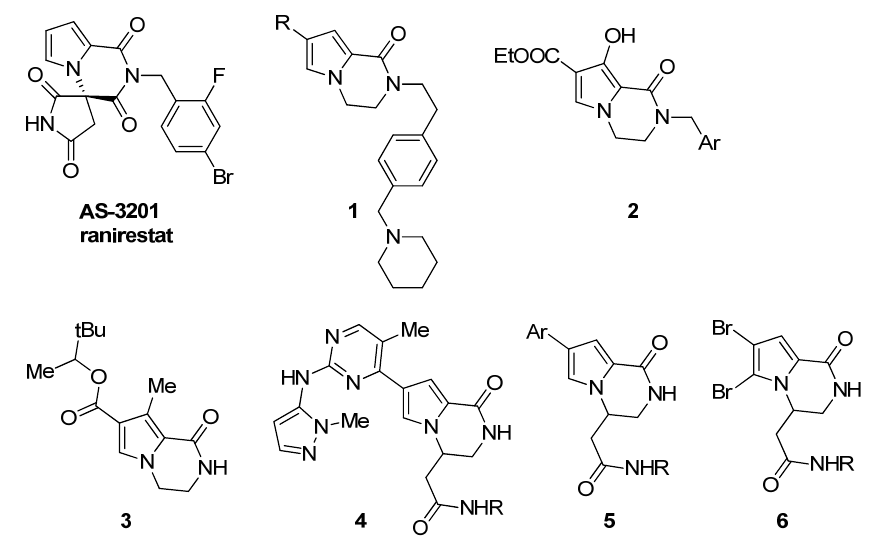
Figure 2. Synthetic bioactive dihydropyrrolopyrazinones.